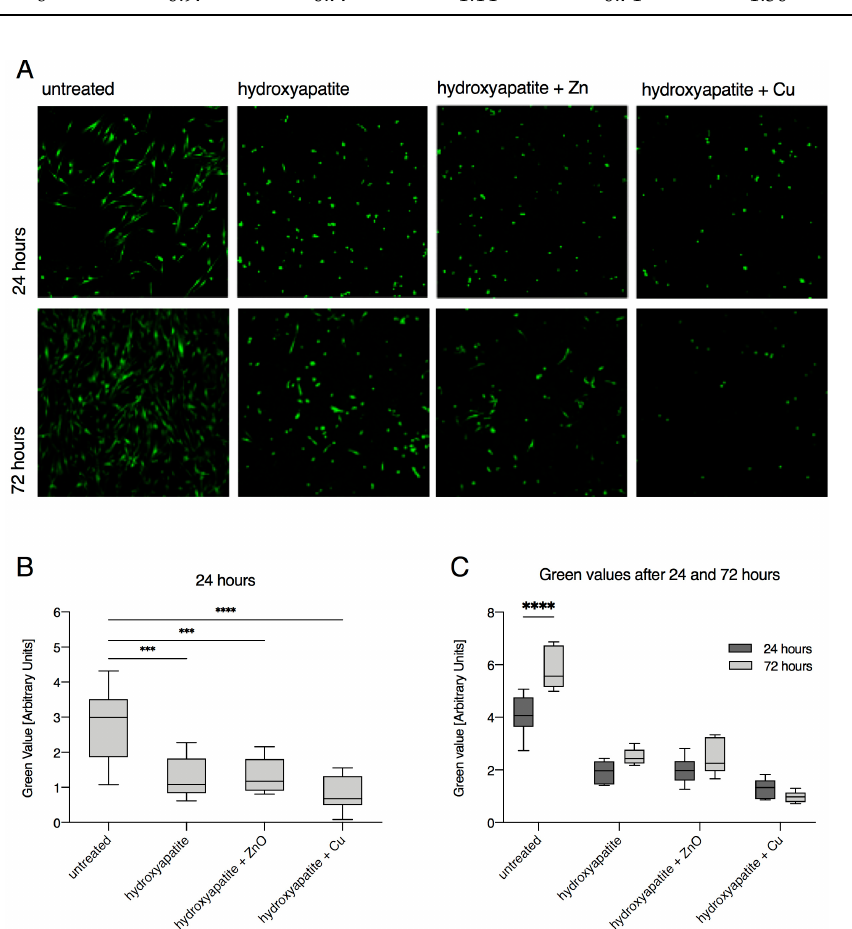
Table 2. Descriptive analysis of surface roughness presented in Figure 2C. Median, percentiles, and minimum and maximum Sa values, measured in µm, are shown.